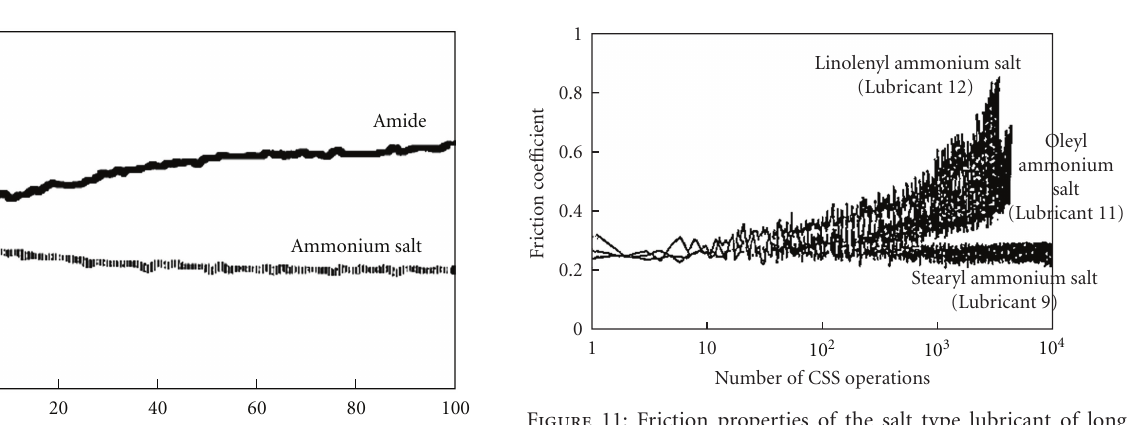
Figure 11: Friction properties of the salt type lubricant of long chain C-18